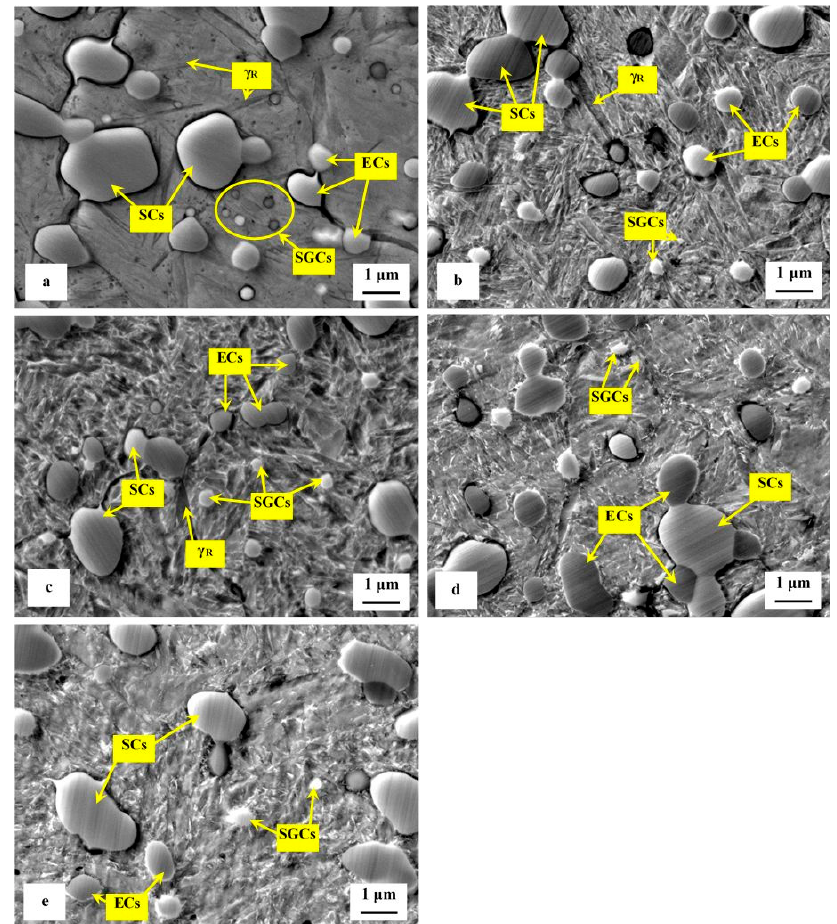
Figure 4. High-magnification SEM micrographs showing the microstructure of SZT steel (for 17 h) in the state after SZT ( a ), and after subsequent tempering at 170 °C ( b ), 330 °C ( c ), 450 °C ( d ), and 530 °C ( e ).